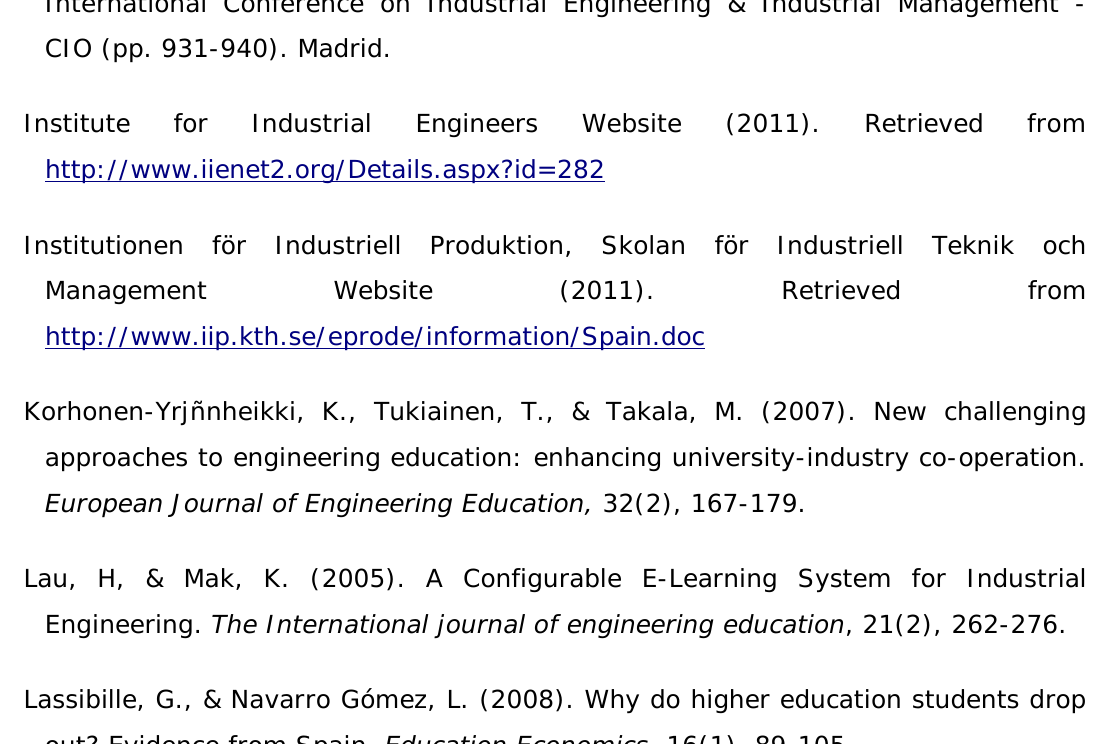
Figuera Figuera, J. R. (2007). Análisis del pasado de la Ingeniería de